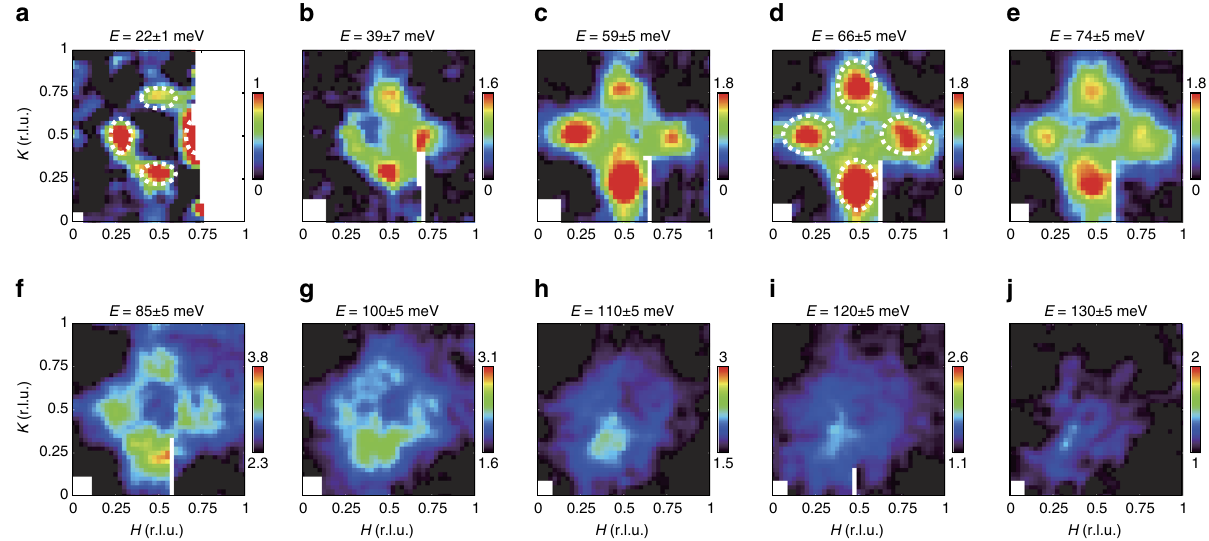
Fig. 2 Momentum dependence of the spin excitations in Li 0.8 Fe 0.2 ODFeSe at T = 5 K. a – j Constant-energy images acquired at 5 K and at indicated energies. | Q | -dependent background was subtracted in a – e (Supplementary Note 4). For energies ≥ 85 meV, raw data are presented, f – j . The measurements in a and b – j were conducted at the incident neutron energies of 49.6 and 191.6 meV, respectively. Symmetry equivalent data were collected and averaged to enhance statistical accuracy. The color bar indicates scattering intensity in unit of mbr sr − 1 meV − 1 f. u. −